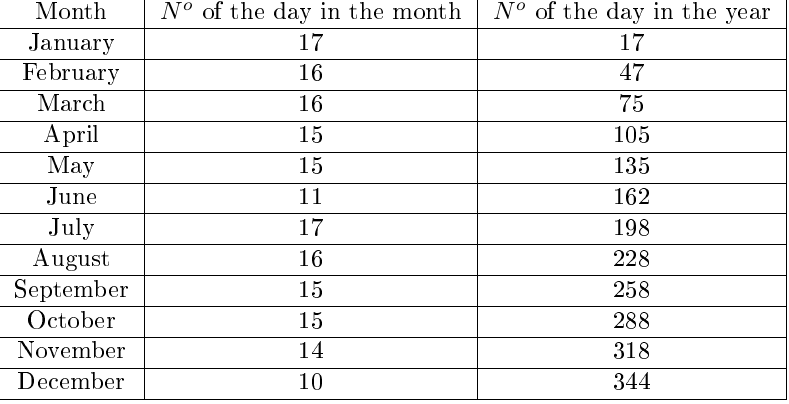
Table 2. Number estimation of the day of the year.